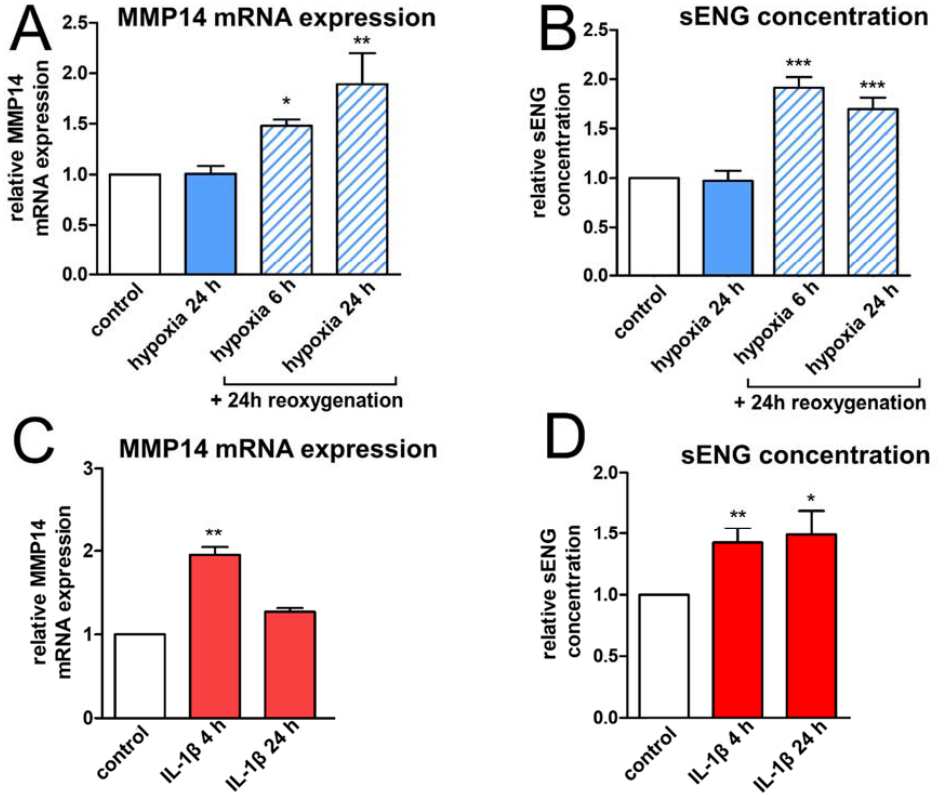
Figure 2. Increased matrix metalloproteinase-14 (MMP14) expression of human brain endothelium goes hand in hand with shedding of soluble endoglin (ENG). ( A ) MMP14 mRNA concentrations by quantitative real-time PCR in HBMEC after hypoxia (1% O 2 ) or hypoxia/reoxygenation for the indicated durations relative to an unstimulated control. Data of three independent